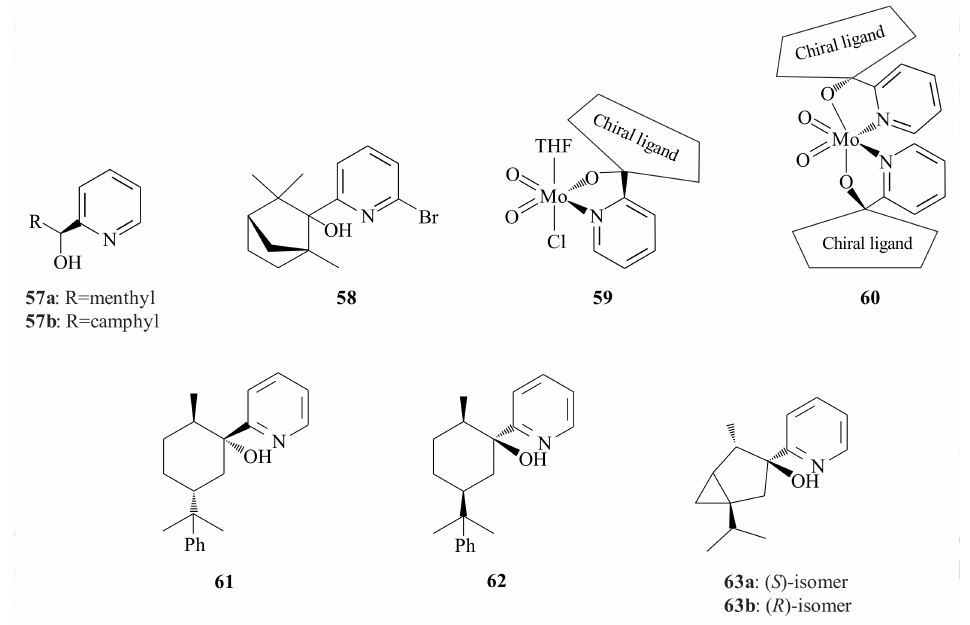
Figure 11. Chiral pyridinyl alcoholato ligands and Mo